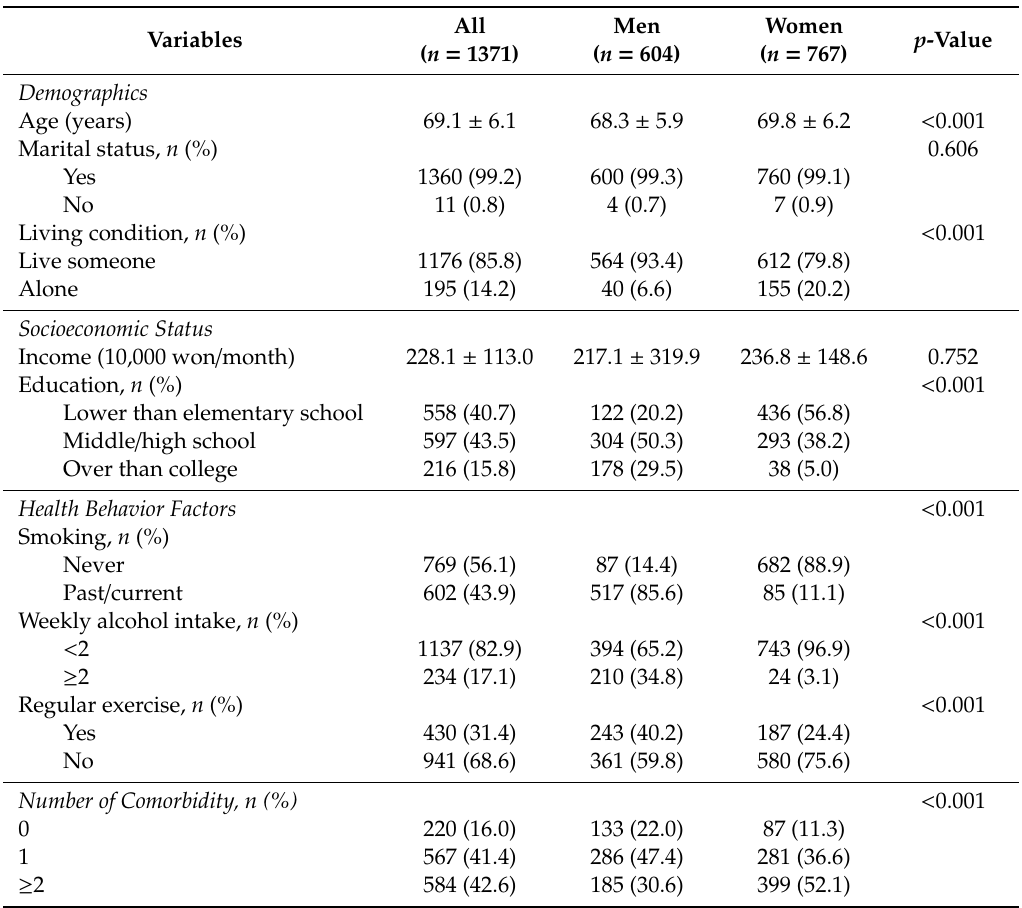
Table 1. Descriptive statistics of study participants (Mean ± SD).